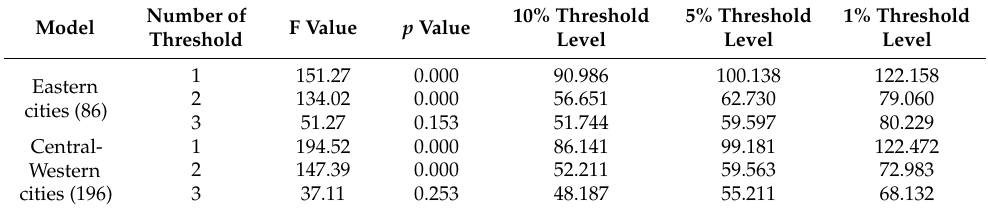
Table A2. The results of panel threshold effect of robust test model. Model